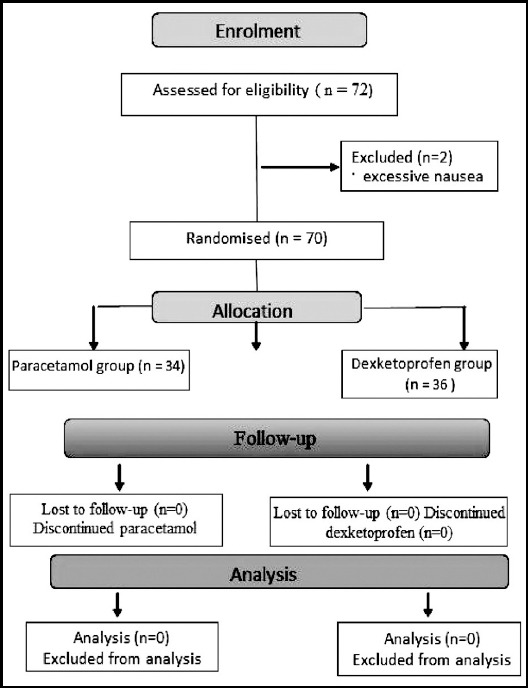
Flow chart of the study design. Administration of the study drug was started before the surgery and then repeated at 6-h (paracetamol) and 8-h (dexketoprofen) intervals for at least 24 h. Scores were then recorded at 24 h after surgery.